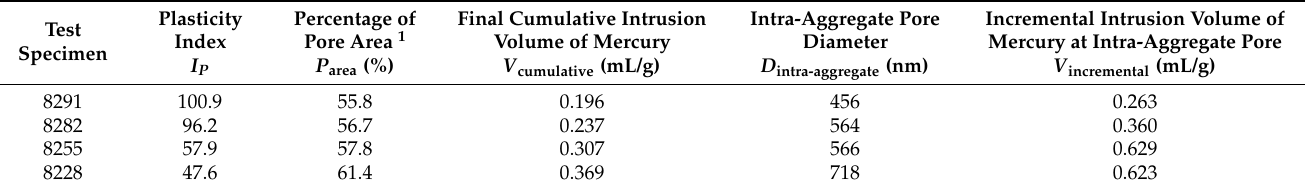
Table 7. The result of the fabric in artificial marine clays by LVESEM test and MIP test. Test